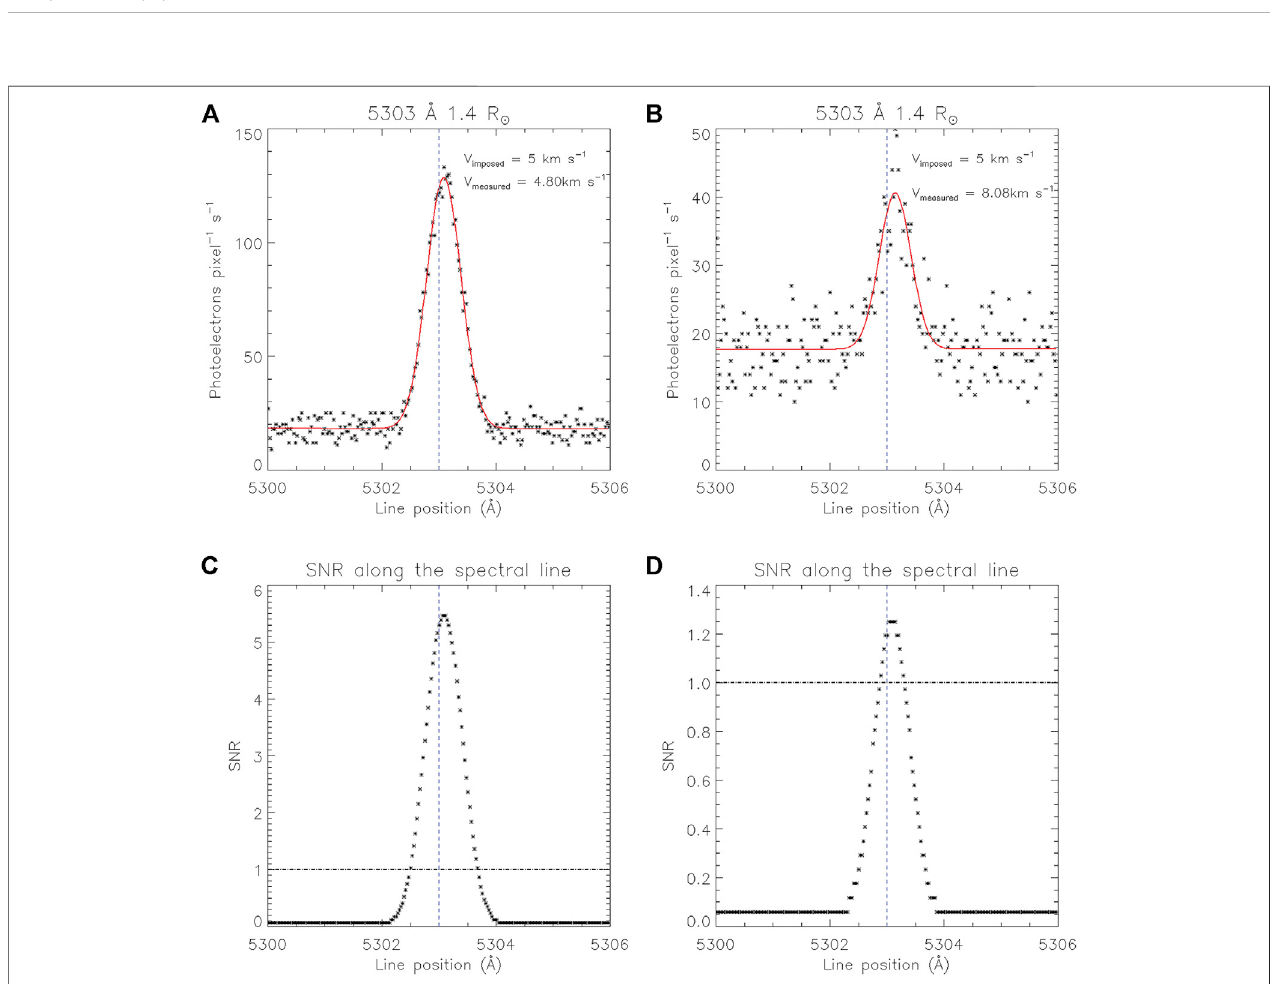
FIGURE5| SyntheticgreenlinewithnoiseandDopplershiftadded (A) at1.4R ʘ and (B) at20%intensityof (A) .Theverticaldashedlineshowstherestwavelength. (C) and (D) show SNR variation within the spectral line, respectively, for (A) and (B) where the horizontal dotted-dashed line marks the SNR (cid:1) 1.